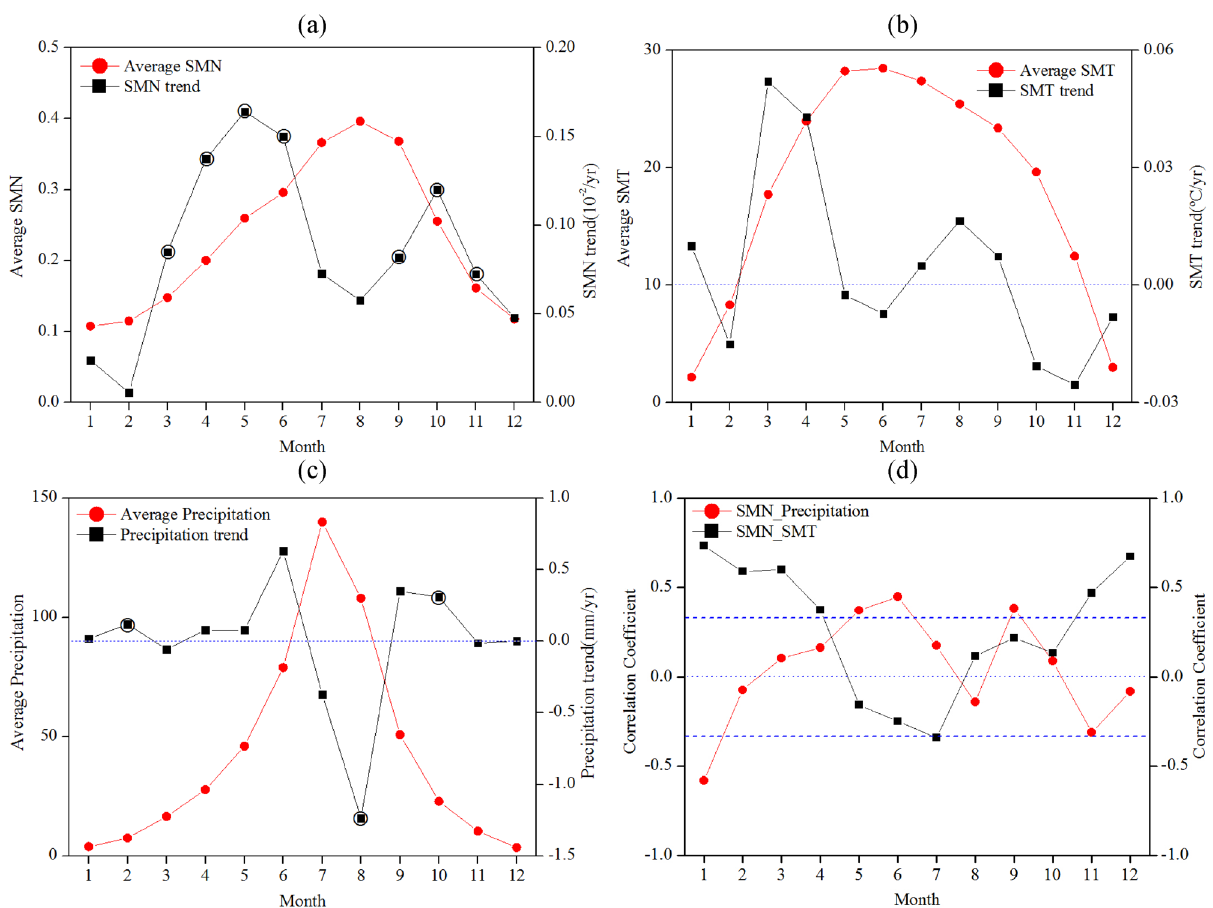
Figure 2. Thirty-five year regional average values and trend magnitudes of monthly SMN, SMT, precipitation and their correlations for the period of 1982–2016 in Jing-Jin-Ji region. ( a ) SMN; ( b ) SMT; ( c ) precipitation; and ( d ) Correlation coefficients between SMN and SMT/precipitation. The empty circles indicate statistically significant trends at 5% significance level, and the dash lines indicate that the SNM is significantly correlated with SMT or precipitation at 5% significance